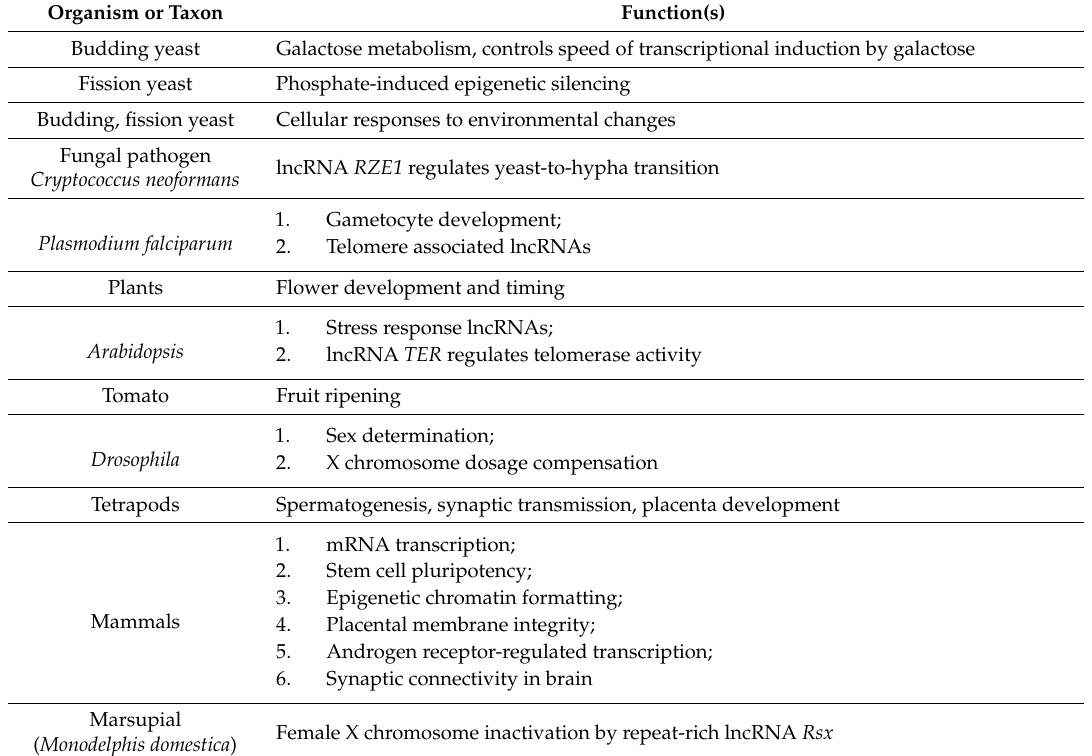
Table 14. Diverse Regulatory Functions Reported for Long Non-coding lncRNA